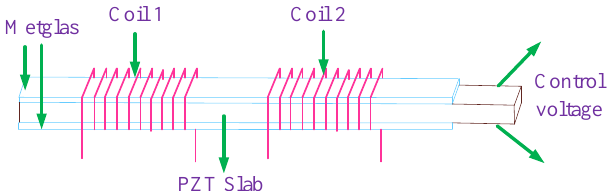
Figure 12. A WPT system with tunable mutual inductance device with lead zirconate titanate (PZT)